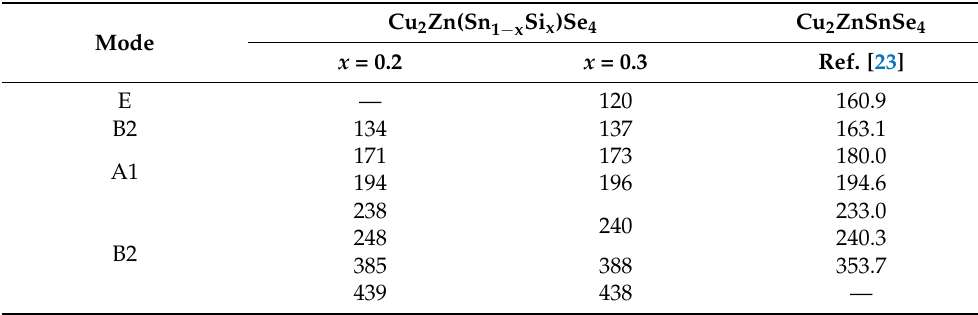
Frequency and proposed mode assignment of Raman peaks from solid